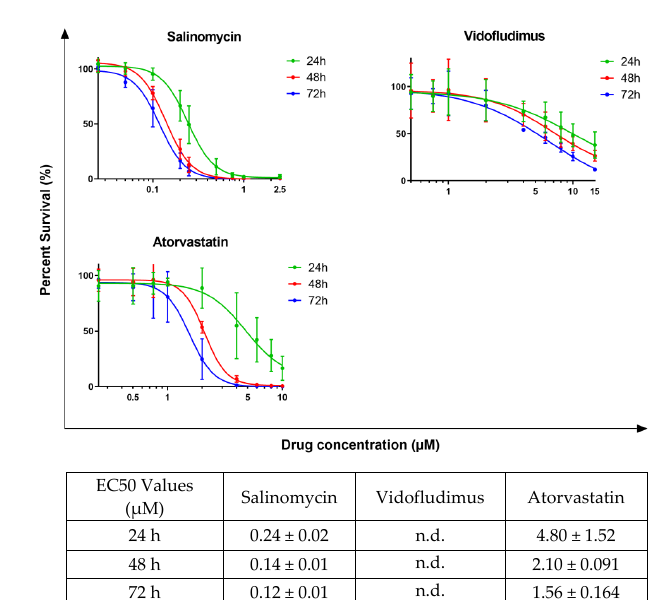
Figure 4. Candidate drug dose response assays for mAF9 cells in liquid culture. ( A ) Line graphs showing viability of mAF9 cells (as percentage survival) over time following drug treatment at the indicated dosage as compared to 0.2% DMSO vehicle control. Mean values ± standard deviation of biological replicates (N = 4, n = 3) are plotted throughout. ( B ) Calculated EC50 values for each candidate drug at 24, 48, and 72 h following treatment.